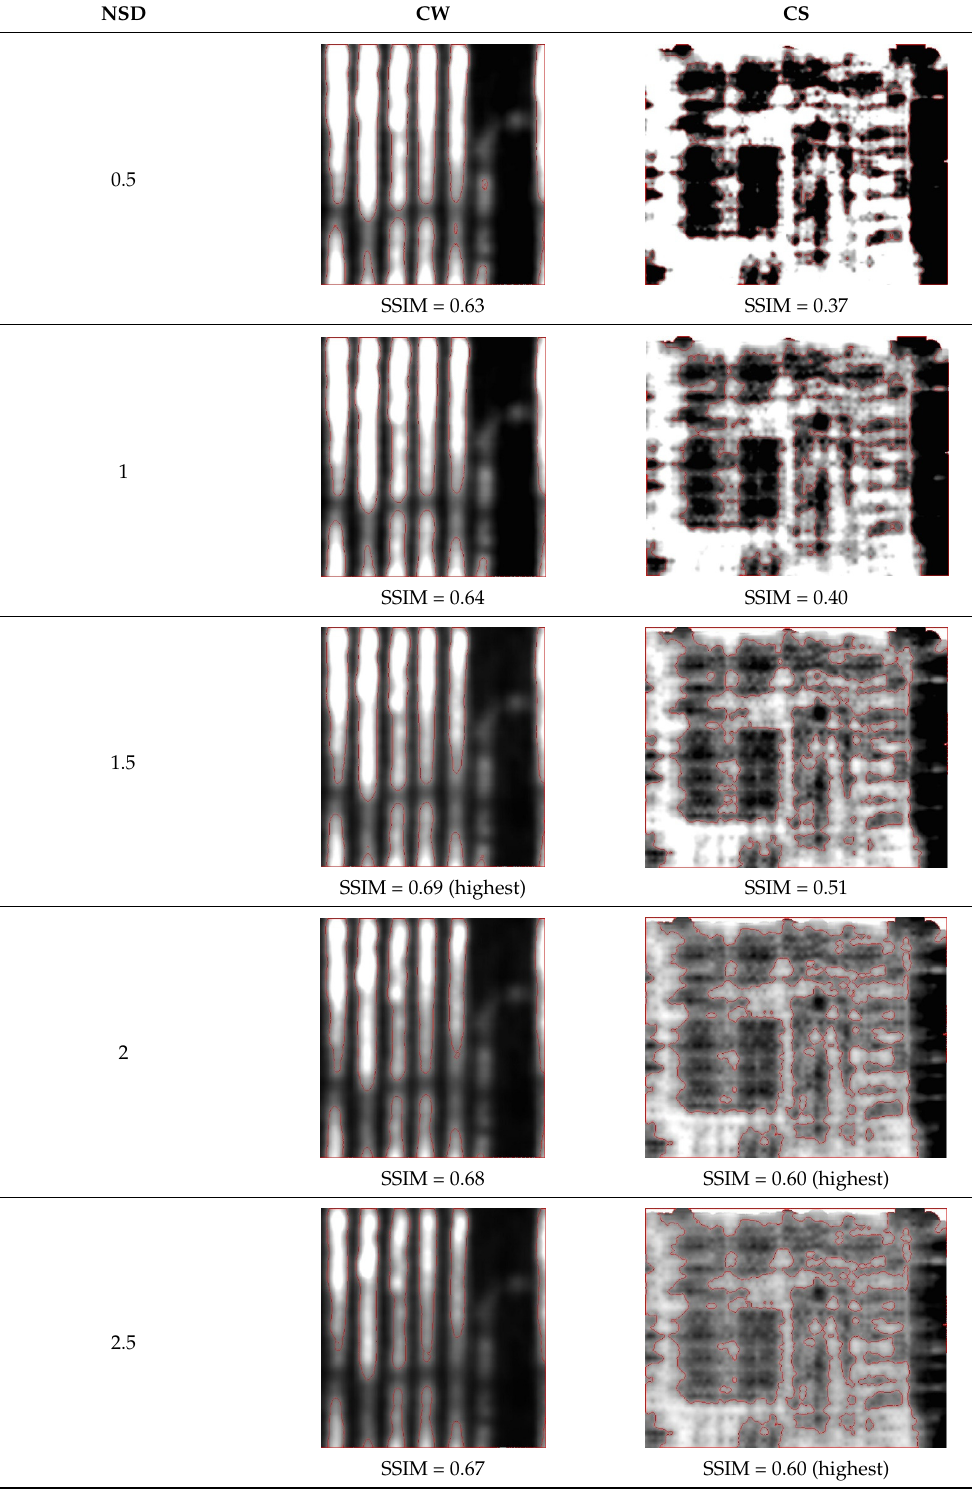
Table 3. Visulisation results of reinforced concrete structure cases with different thresholds.